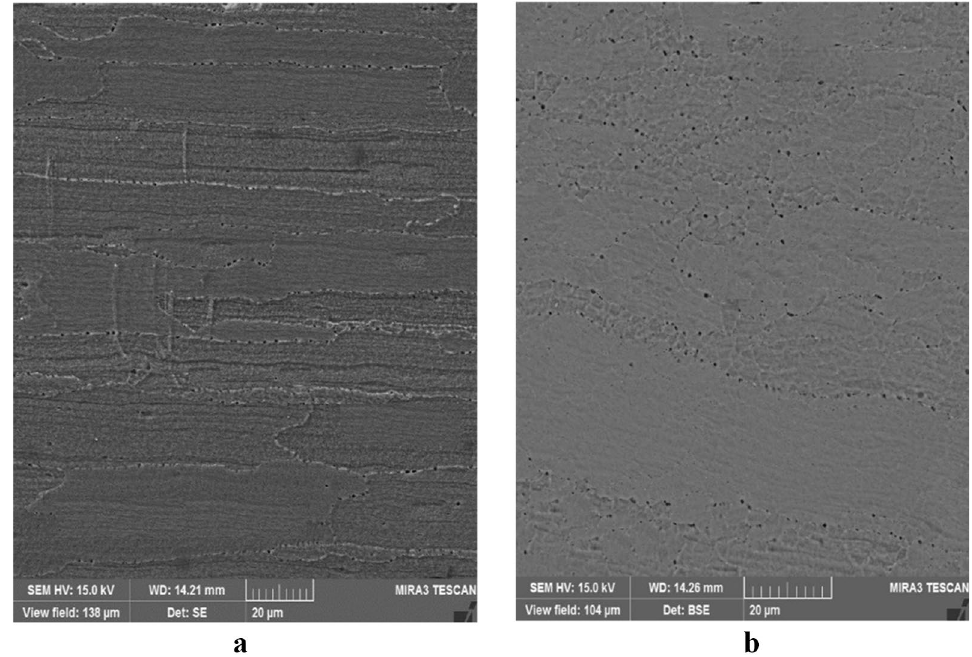
Figure 14. SEM images of the stir zone in the optimal samples: ( a ) conical pin, ( b ) threaded cylindrical